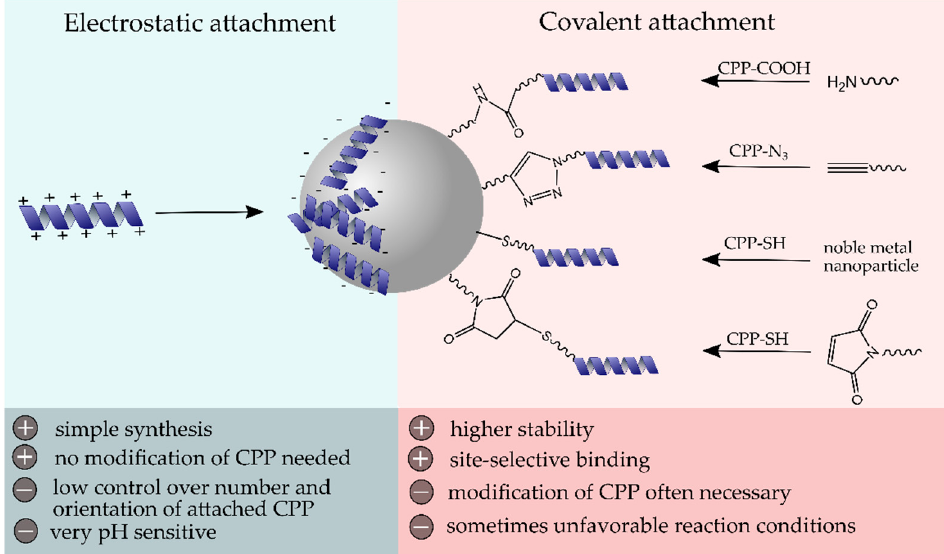
Figure 2. Schematic surface modification of NPs with cell-penetrating peptide (CPP) using electrostatic or covalent coupling strategies and their major advantages and disadvantages.